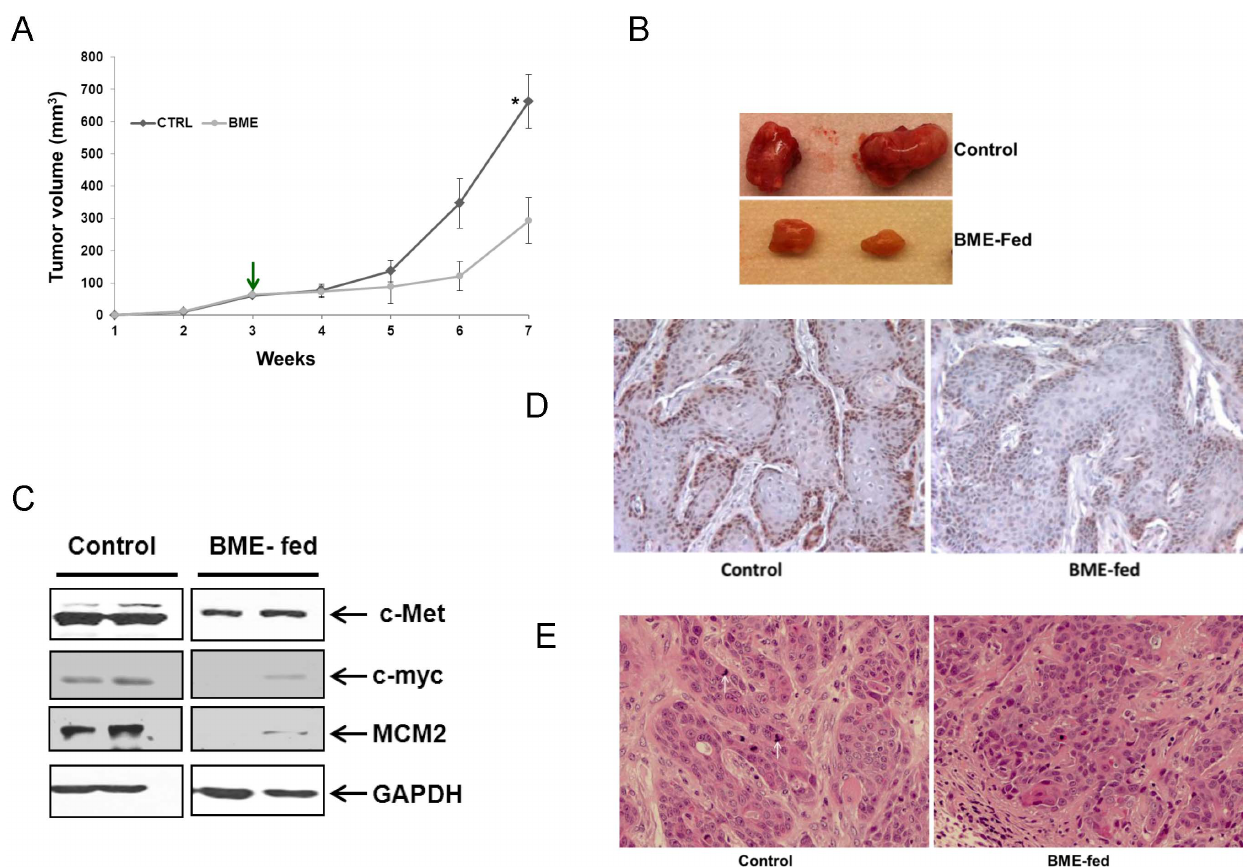
Figure 5. Oral BME administration in Cal27 xenograft nude mice reduces tumor growth. (A). Cal27 cells were implanted subcutaneously into the flank of athymic nude mice. Tumor bearing mice were randomized into two groups, and water (control) or BME was gavaged orally for 4 weeks (5 day/wk). Down arrow indicates the BME or water gavage start time. Volume of tumor growth was monitored once a week and presented as a mean. Small bar indicates standard error (*, p , 0.05). (B). Representative tumors dissected from the control and BME-fed mice are shown. (C). Western blot of c-Met, c-myc and MCM2 in xenograft tumor tissues isolated from both control and BME fed mice. The blot was reprobed with an antibody to GAPDH for comparison of protein load. (D). The immunohistochemical staining for PCNA in representative tumor section of a control and BME-fed mice (magnification, 40 6 ) are shown. (E). A representative tumor section from control or BME-fed mice stained with hematoxylin and eosin (magnification, 40 6 ) are shown. Arrows indicate the